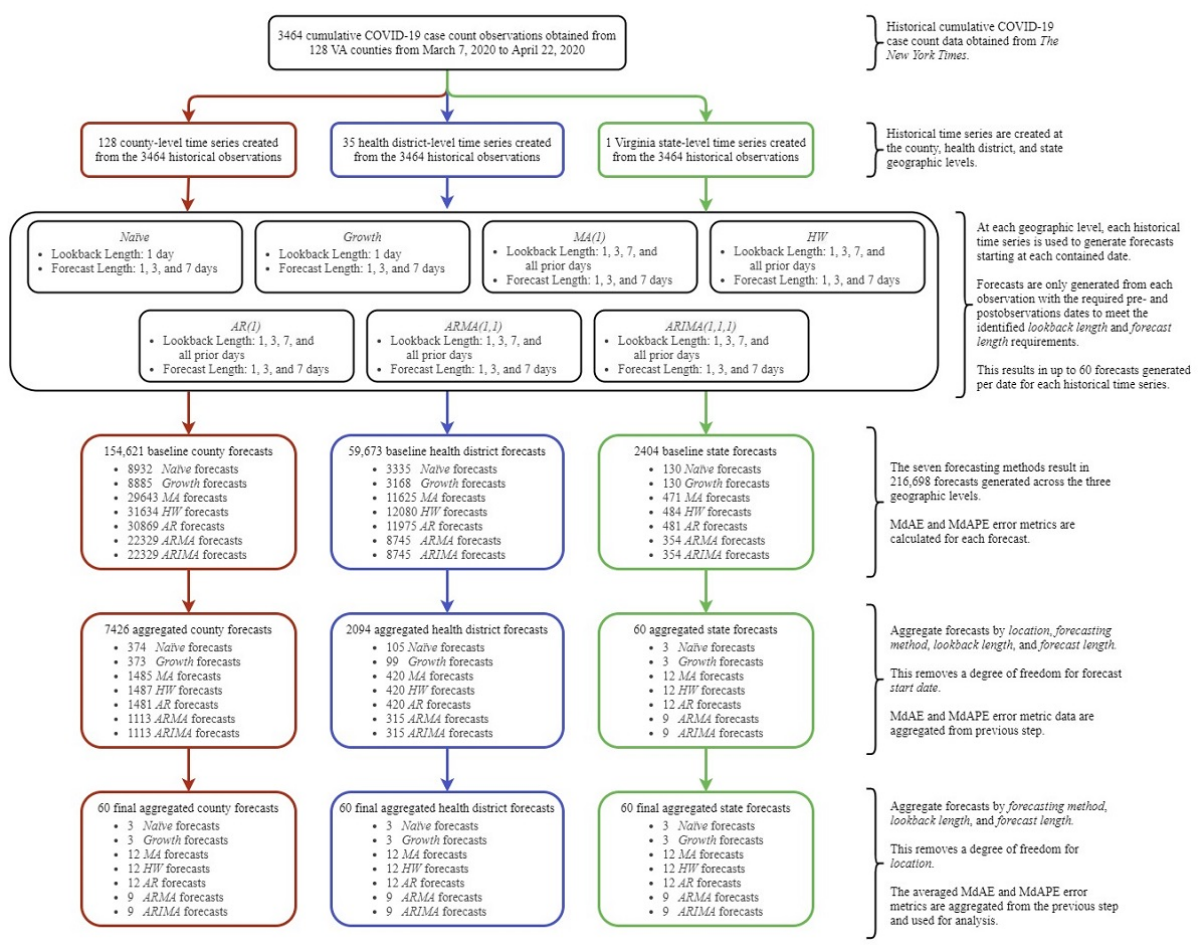
Figure 1. Experimental design and data overview at the county, health district, and state levels. The generation and aggregation of county-level forecasts are shown on the left path (red), health district–level forecasts on the middle path (blue), and state-level forecasts on the right path (green). The information on the right provides additional detail on each stage in the experimental design. AR: autoregressive; ARIMA: autoregressive integrated moving average; ARMA: autoregressive moving average; HW: Holt-Winters; MA: moving average; MdAE: median absolute error; MdAPE: median absolute percentage error; VA: